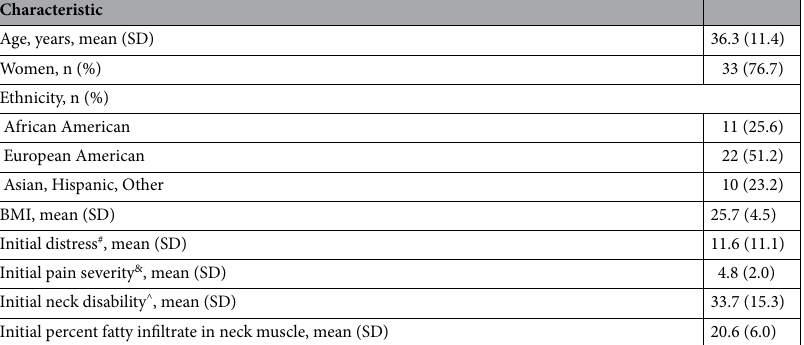
Table 1. Baseline characteristics of study participants (n = 43). MVC, motor vehicle collision trauma; SD, standard deviation; ED, emergency department. # Distress was measured with the hyperarousal subscale of the PDS inventory & Pain severity was measured using the numeric rating scale (0–10 NRS). ^ Neck disability was measured with the Neck Disability Index (range